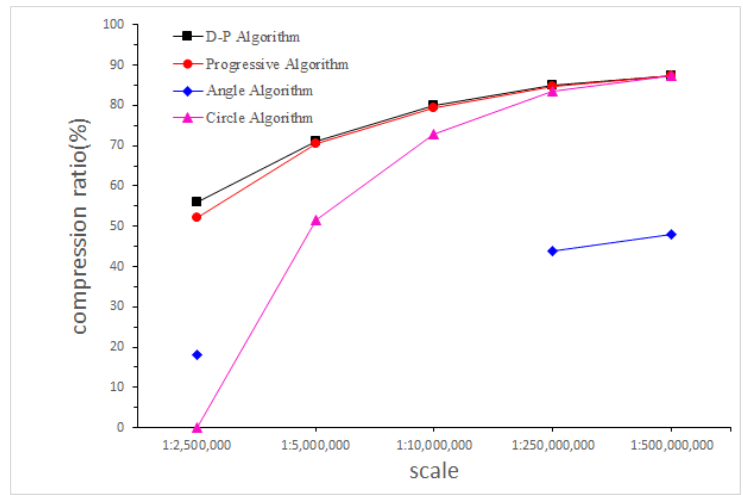
Figure 9. The compression ratio of the four simplification algorithms.